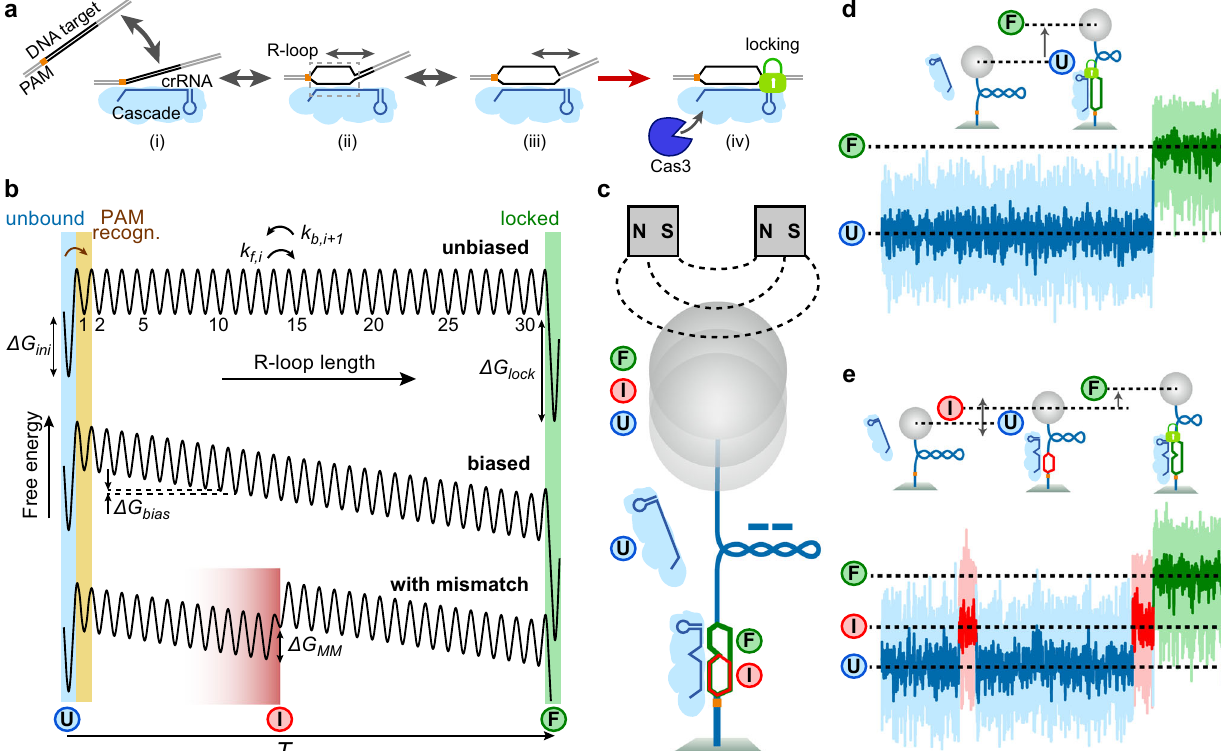
Fig. 1 | Random-walk model for target recognition by Cascade. a Target recognitionstarts with PAMbinding (i) followed by R-loop priming adjacent to the PAM. The R-loop can expand in a reversible random-walk like fashion towards the PAM distal end of the target (ii). After reaching the PAM distal end (iii), a con- formational change is induced that locks the R-loop in a stable conformation and enables Cas3 recruitment and cleavage of the DNA (iv). b Simpli fi ed one- dimensional free energy landscapes for R-loop formation. Local energy states are the unbound state ( U ), the R-loop states of different length and the locked full R-loop ( F ). R-loop expansion and shrinkage occurs in successive forward or back- ward steps to either adjacent state. Shown free energy landscapes correspond to R-loopformationwithoutanenergybias(top),withanegativebiasasexpectedfor